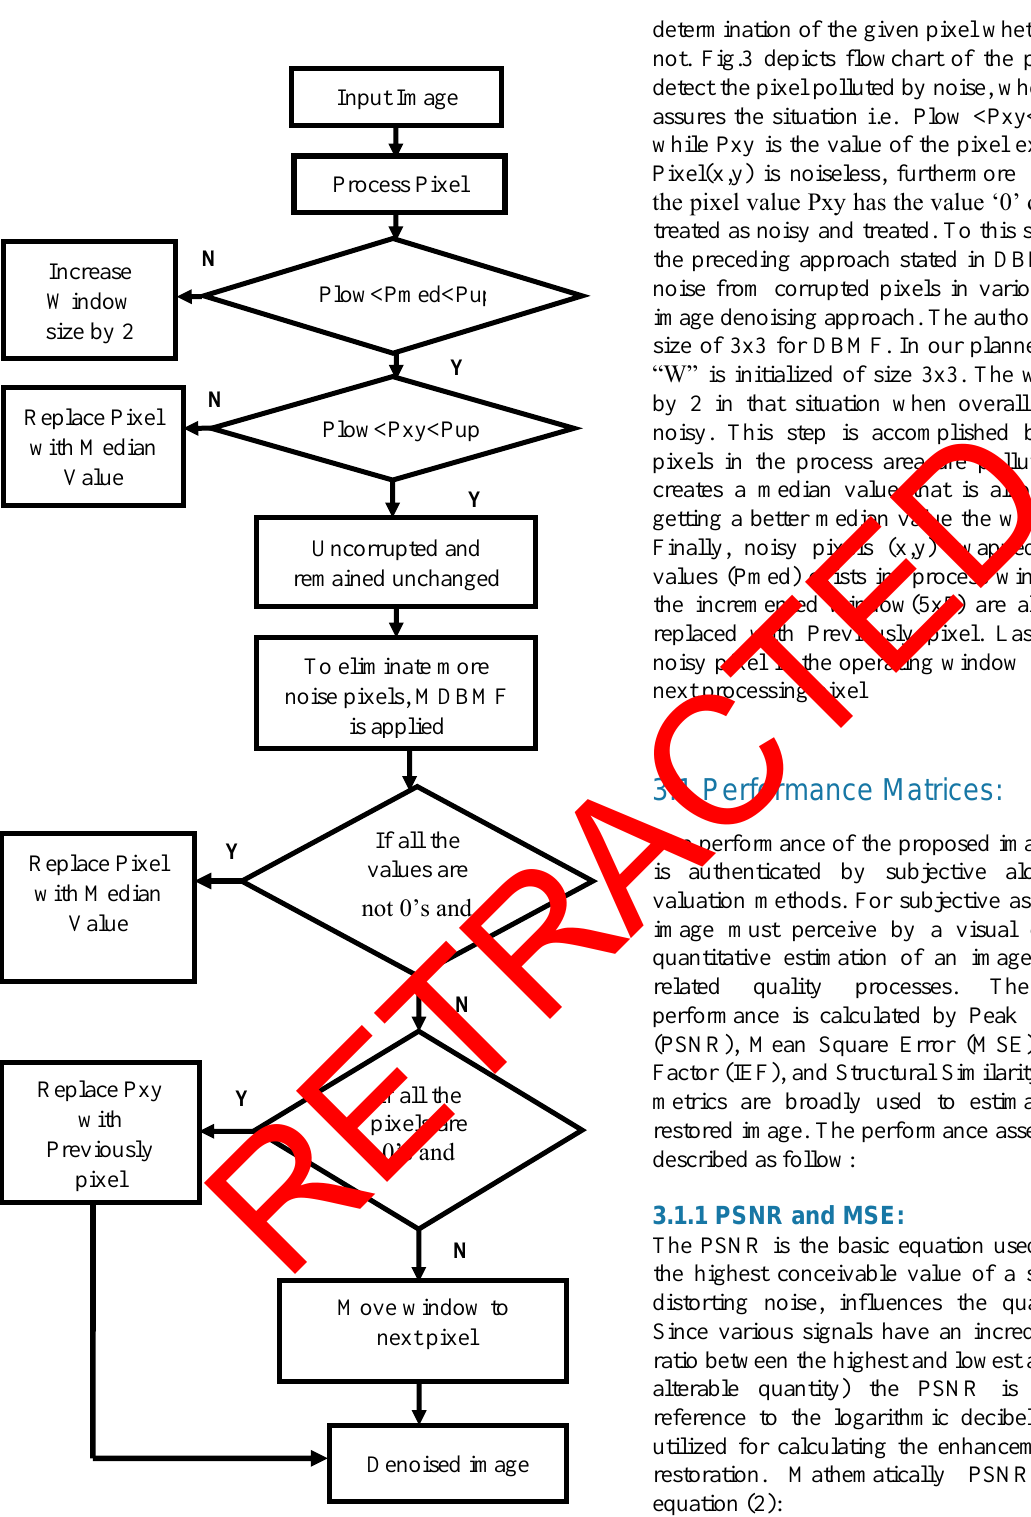
Figure 3. Flowchart of proposed